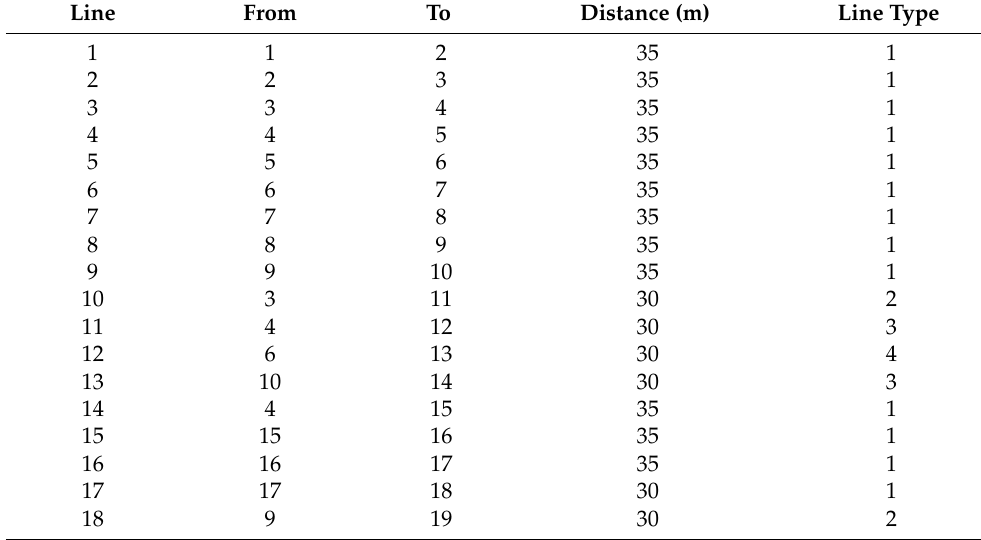
Table A2. Node connection for the CIGRE low-voltage test system. Line From To Distance